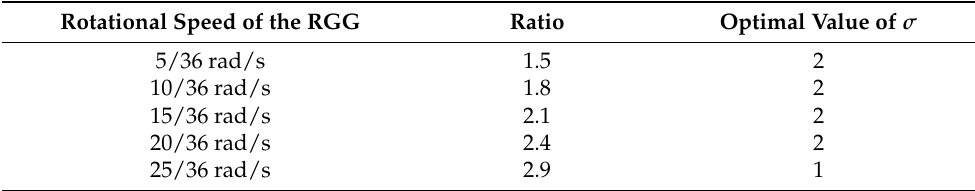
Table 1. The ratio and the optimal value of σ under different rotational speeds of the RGG.